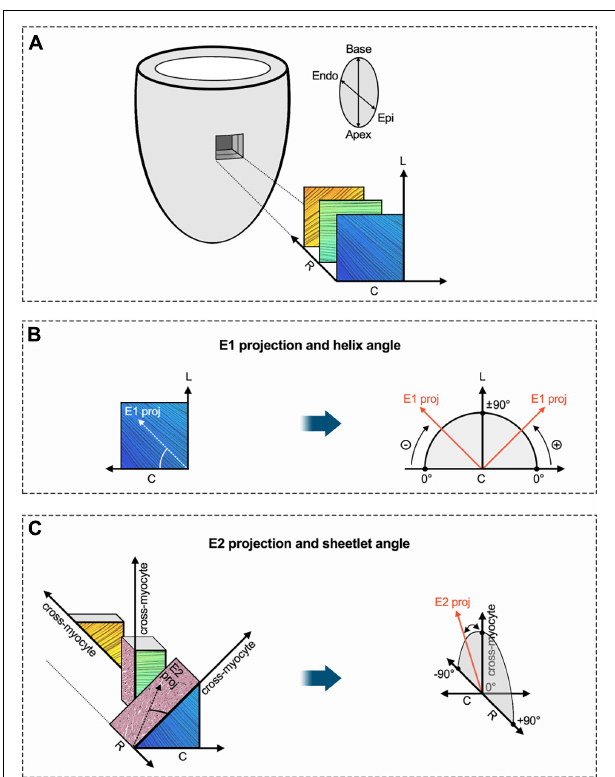
FIGURE 6 | Schematic diagram of helix angle and sheetlet angle. (A) Transmural region of interest of the LV with exemplary visualization of subendocardial, mesocardial and subepicardial layers (fiber bundle excerpts are based on tractography in respective myocardial layers). In order to determine established DT-MRI metrics such as helix and sheetlet angle, a local coordinate system with circumferential, longitudinal, and radial axes is established for every voxel. (B) The primary eigenvector of the diffusion tensor (E1) was projected into the local tangential plane (given by local circumferential and longitudinal axes). The angle between E1 projection and the circumferential axis provides the so-called helix angle. As depicted in panel (A) , myofibers in the LV are arranged in two counter-directional helices with progressively changing pitch (positive in the subendocardium over neutral in the mesocardium to negative in the subepicardium). (C) The local cross-myocyte plane (given by local cross-myocyte orientation and radial axis) was determined perpendicular to the local primary eigenvector orientation (myofiber bundle orientation). A projection of the secondary eigenvector (E2) was placed in this cross-myocyte plane in order calculate the sheetlet angle E2A, which is defined as the angle between cross-myocyte direction and E2 projection. The metric aims to assess the impact of sheetlet and shear layer microstructure on diffusion components. Various cross-myocyte directions at different transmural levels (subepicardial, mesocardial, subendocardial) are depicted. Adapted from Ferreira et al. (34). C, circumferential; Endo, endocardium; Epi, epicardium; E1, primary eigenvector of the diffusion tensor; E2, secondary eigenvector of the diffusion tensor; L, longitudinal; R,